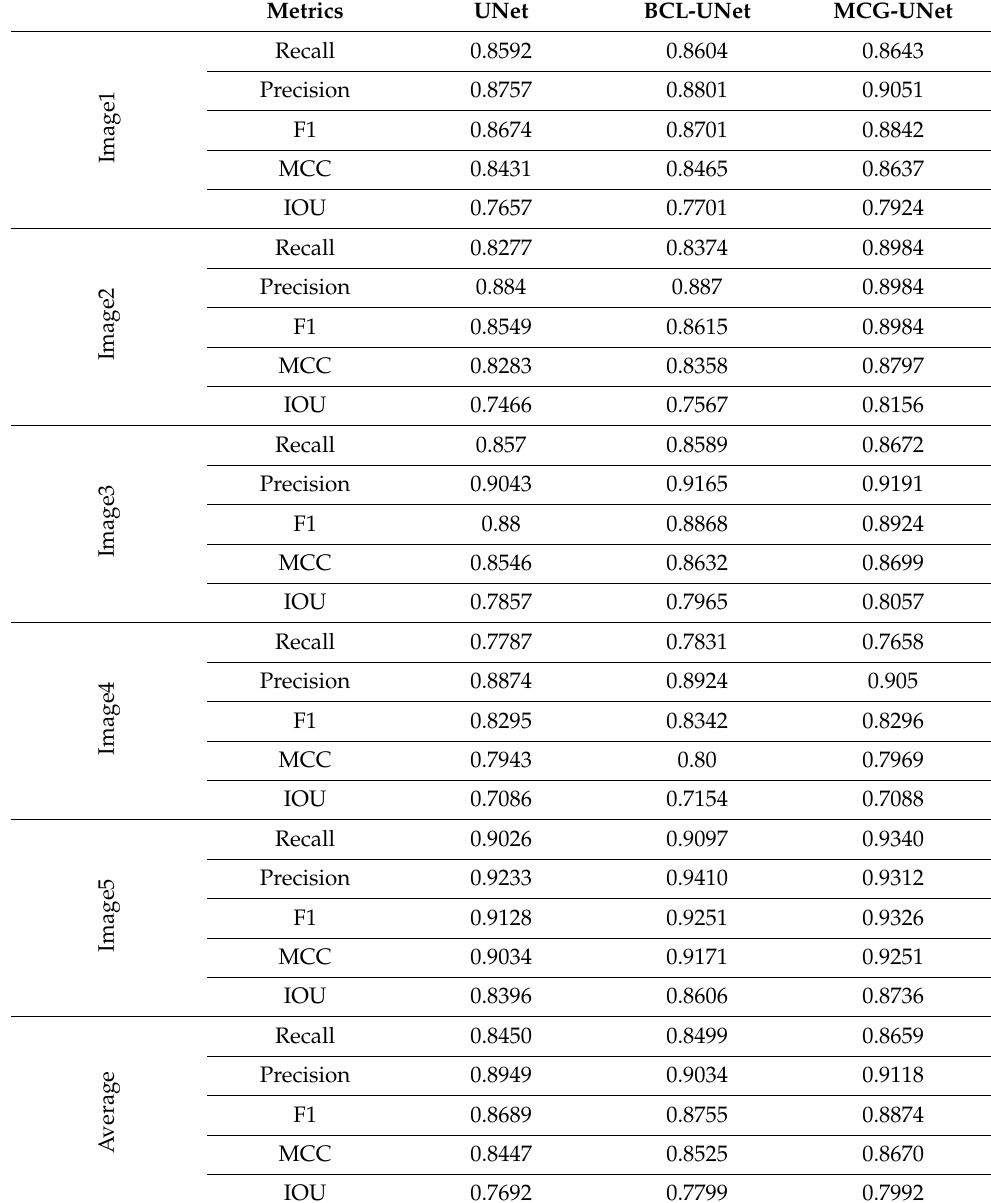
Table 2. Comparison of the MCG-UNet, BCL-UNet, and UNet networks for road segmentation.